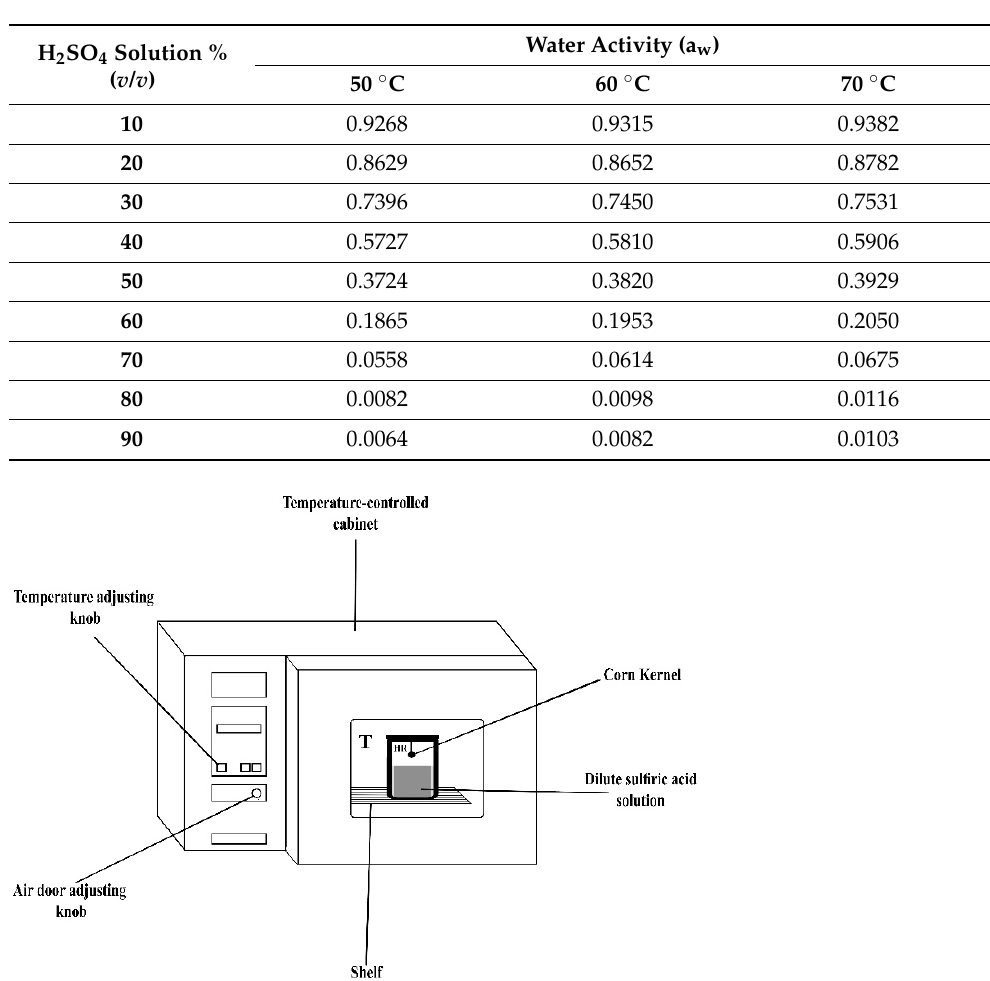
Table 4. Water activity of sulfuric acid solutions at specific concentrations and temperatures ranging from 50 to 70 °C for the corn kernels.